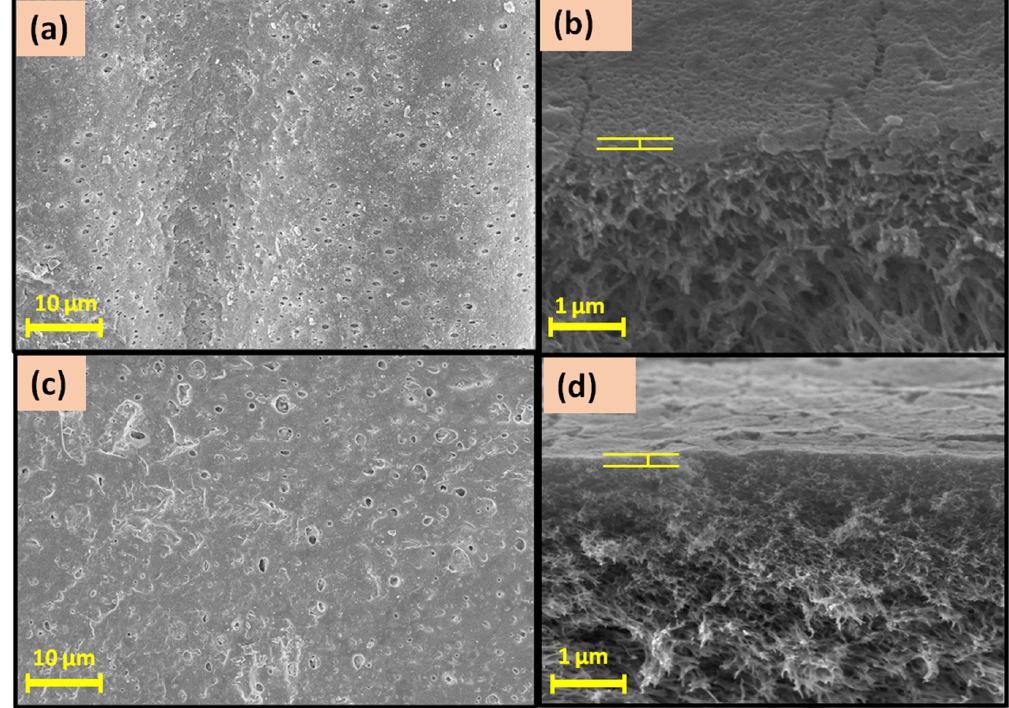
Figure 4. FE-SEM images of (a) surface view of M1 and (c) surface view of M2 membrane and the cross-section images of (b) M1 membrane and (d) M2 membrane. Table 2. Contact angle measurements of polysulfone and prepared M1, M2 membrane.